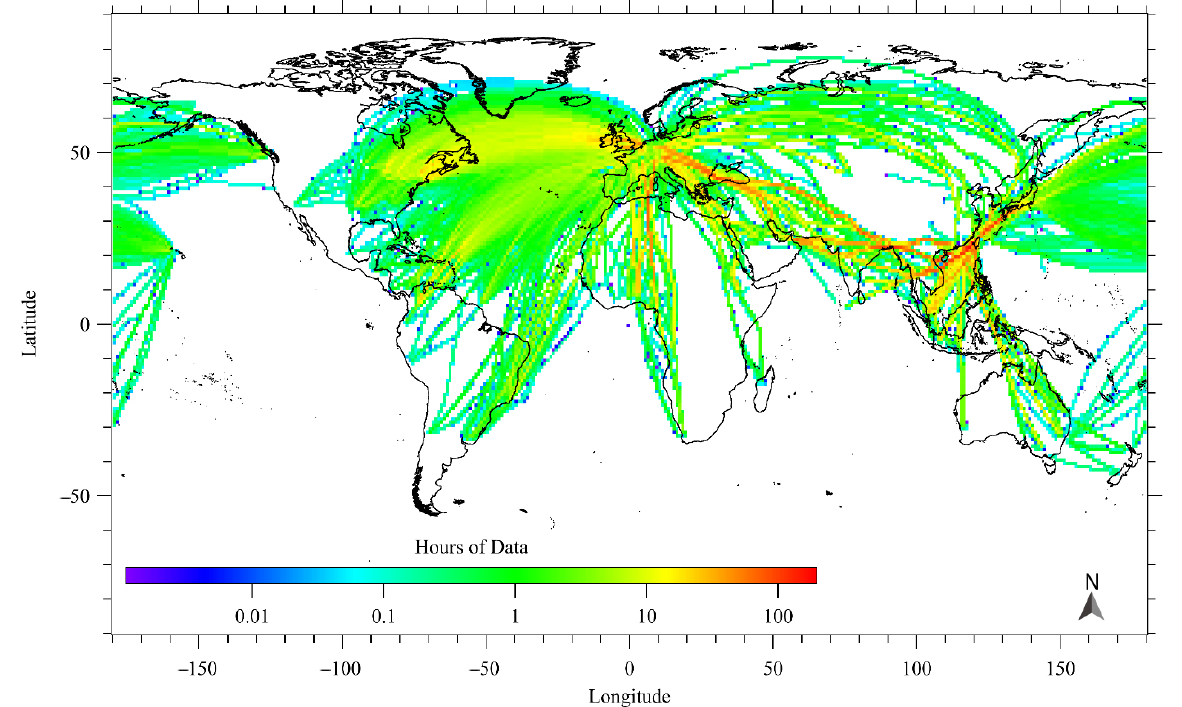
Figure 3. Global measurement hours by the backscatter cloud probe on the IAGOS fleet of Airbus